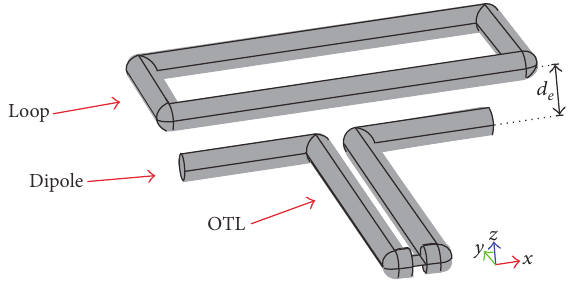
Figure 1: Nanocircuit, consisting of a two-wire optical transmission line (OTL), a dipole antenna (straight dipole), and a loop antenna